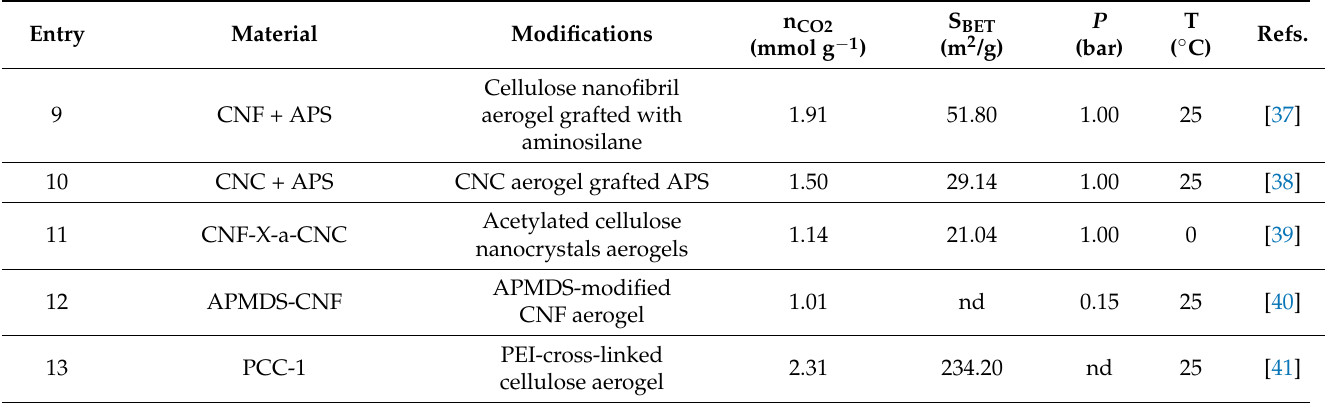
Table abbreviations: nd, no data; n CO2 , CO 2 capture capacity; S BET , specific surface area; CHT, chi- tosan; GO, graphene oxide; PVA, poly(vinyl alcohol); TPPS, meso-tetrakis(4-sulfonatophenyl)porphyrin;